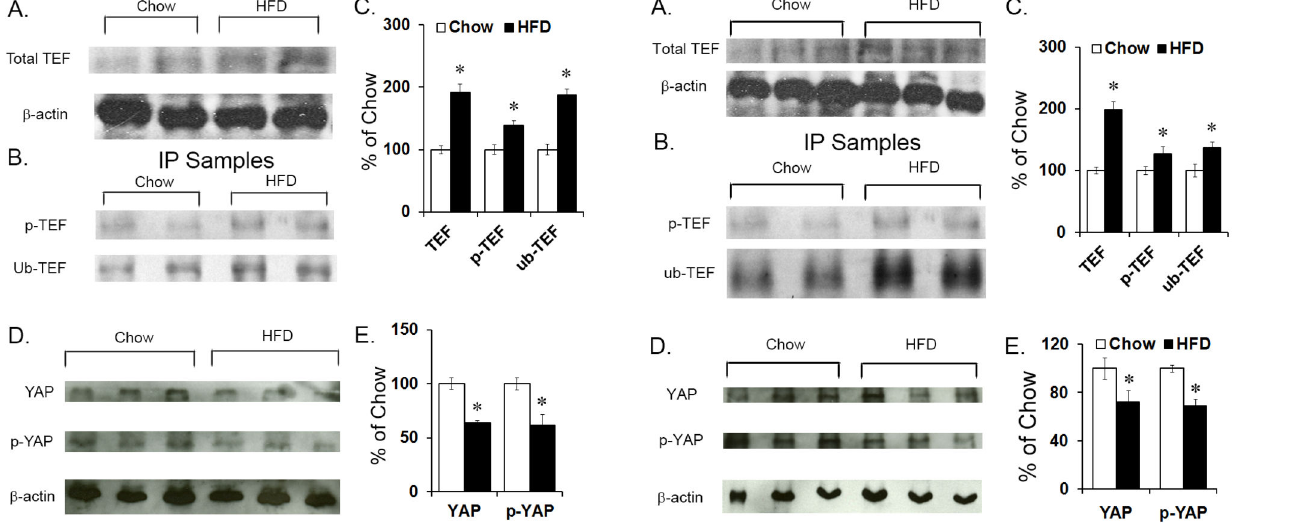
(+27%; t (6) = 2.56, p < 0.05; Figure 4C, D). Plotting of